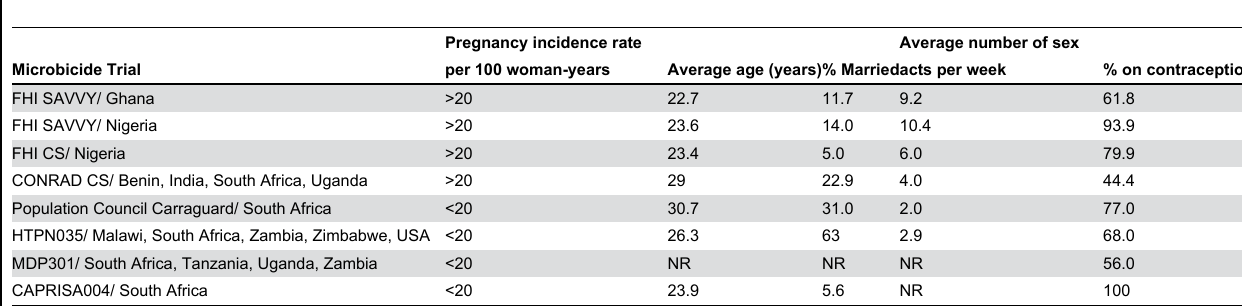
Table 4. Baseline demographic characteristics of women participants as reported in included trials.